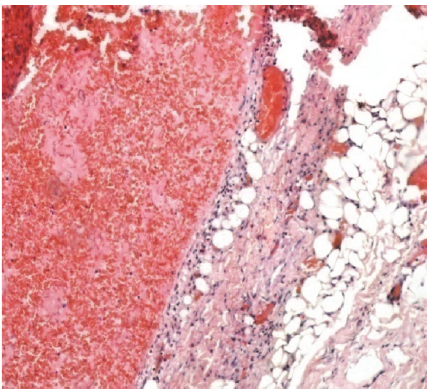
Figure 5: Higher magnification of Figure 4 (H/E, 100x).